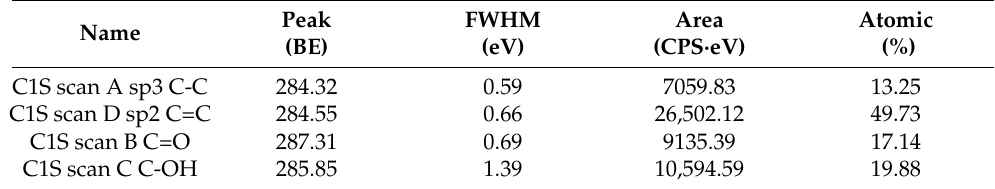
Table 2. Elements identifier and quantitative assessment of shungite samples before sonication.